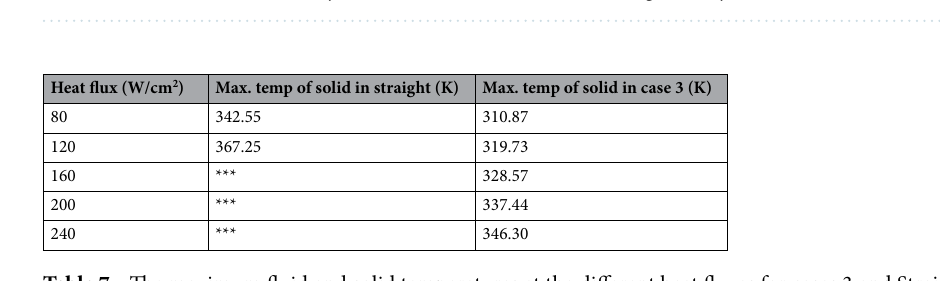
Table 7. The maximum fluid and solid temperatures at the different heat fluxes for cases 3 and Straight microchannels.